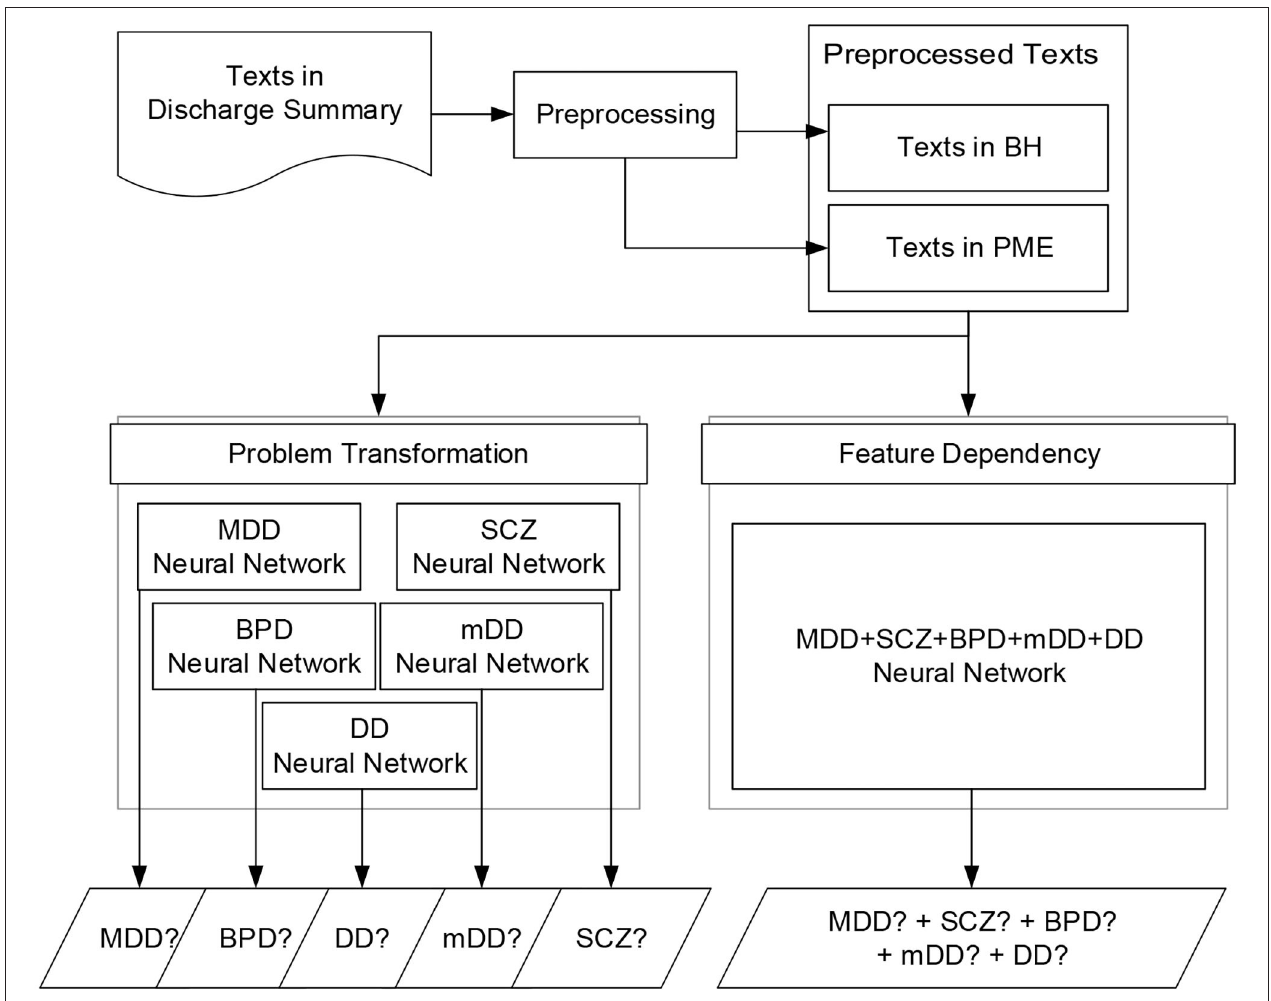
FIGURE 2 | Flowchart of the screening process of the neural networks based on the two methods: problem transformation and feature dependency.